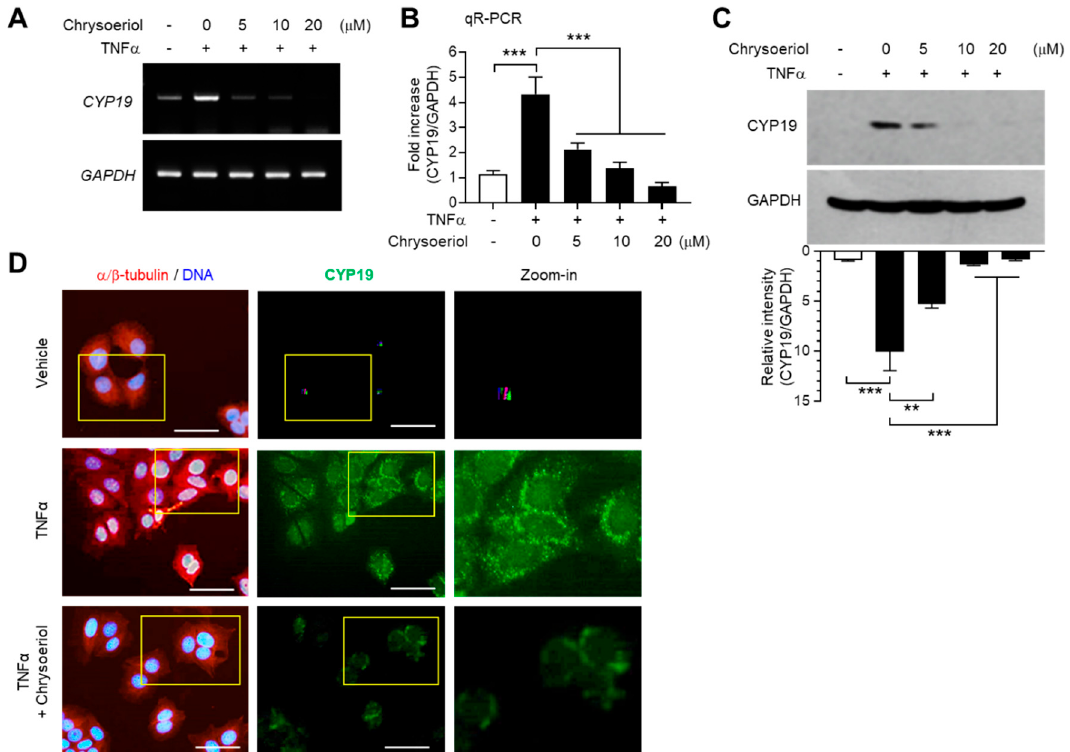
Figure 5. Effect of chrysoeriol on CYP19 expression. ( A – C ) MCF-7 cells were pretreated with chrysoeriol (0–20 µM) for 30 min, followed by treatment with 10 ng/mL TNF α . After 24 h, CYP19 expression was determined by RT-PCR ( A ), qR-PCR ( B ), and immunoblot analysis ( C ). GAPDH was used as an internal control. Band intensities were measured using the ImageJ software. Bars represent the mean ± SD ( n = 3). ** p < 0.01, *** p < 0.001 by Dunnett’s multiple comparisons test. qR-PCR, quantitative real-time PCR. ( D ) MCF-7 cells cultured on coverslips were treated with 10 ng/mL TNF α in the absence or presence of 10 µM chrysoeriol, followed by fixation, permeabilization, and incubation with primary antibodies specific to α / β -tubulin and CYP19 aromatase for 2 h. After washing, Alexa Fluor 555 (for α / β -tubulin; red signal) and Alexa Fluor 488 (for CYP19; green signal) secondary antibodies were used to probe the samples for 30 min. Nuclear DNAs were stained with Hoechst 33258 for 10 min (blue signal). Fluorescently labeled cells were viewed under an EVOS FL fluorescence microscope. Nuclear DNA and α / β -tubulin were overlaid (left panels). Yellow boxed regions are zoomed-in on the far right. Scale bars represent 20 µ m.